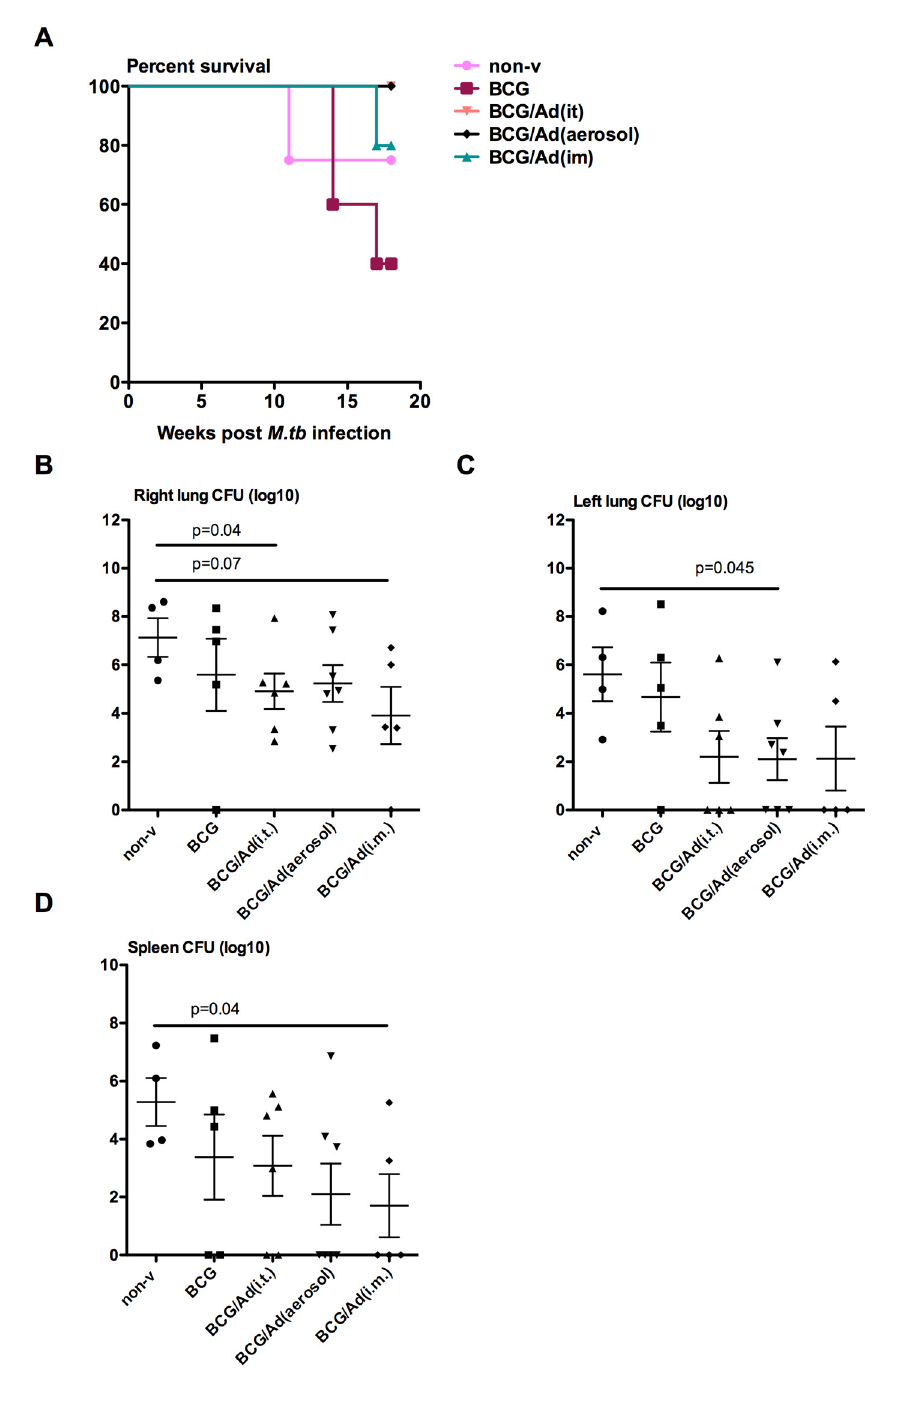
Fig 3. Survival rates and mycobacterial burden in the lung and spleen. Animals were infected with 25 colony-forming units of M . tb Erdman strain. Group coloring in the survival graph is maintained throughout the article for comparability of data. One animal in BCG/Ad(im) group died accidently and is excluded from data analysis ( A ). Overall log-rank test for trend yielded p = 0.0247, but no statistical differences between groups. Colony-forming units (CFU) of mycobacteria was measured per gram of randomly selected tissue from different lung lobs or spleen at necropsy. CFU per right lung ( B ), left lung ( C ) and spleen ( D ) were presented